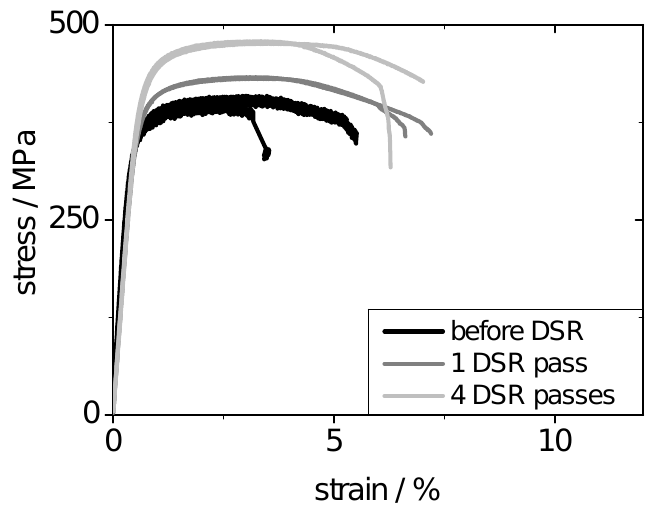
Figure 7. Engineering tensile stress-strain curves of five-layered Ti/Al composites after ARB and further processing by DSR with a speed ratio of 1:1: with one and four DSR passes, respectively. Results for two samples in each condition are shown in order to illustrate the occurring